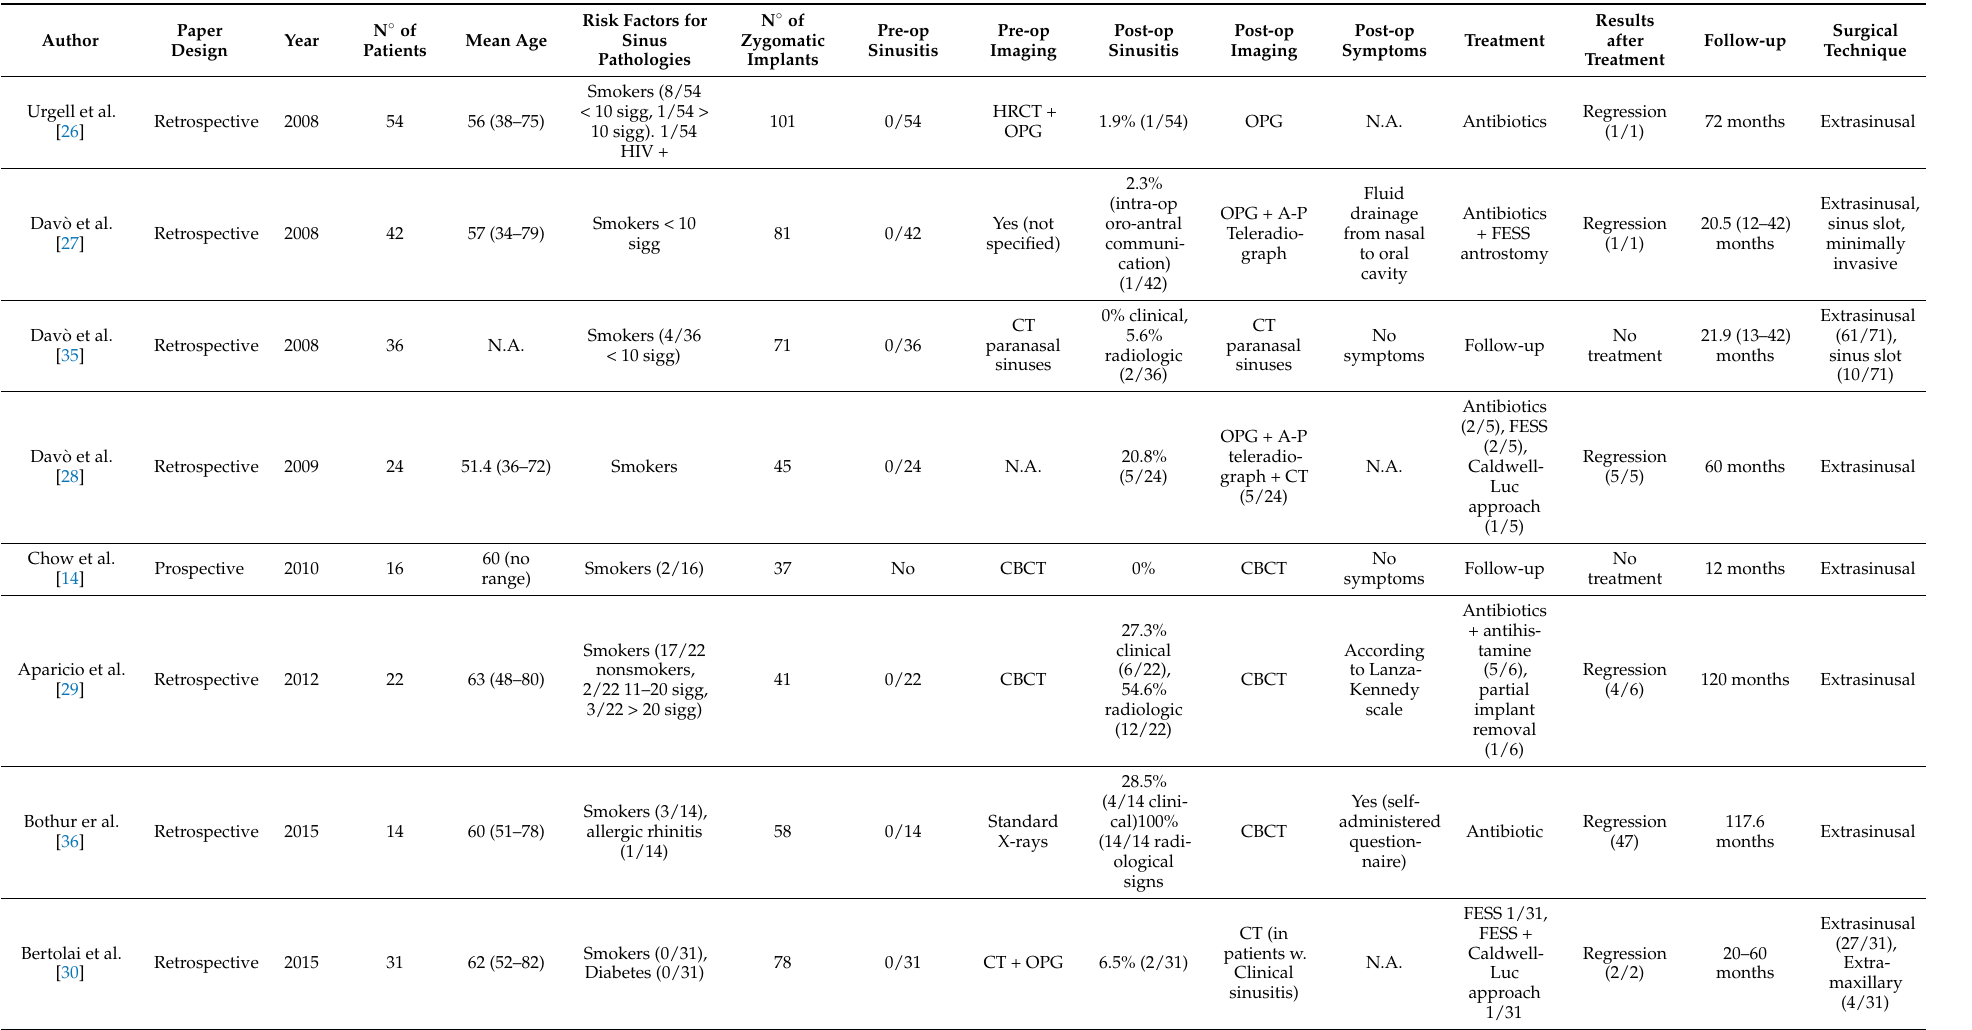
Table 3. Articles considered in the